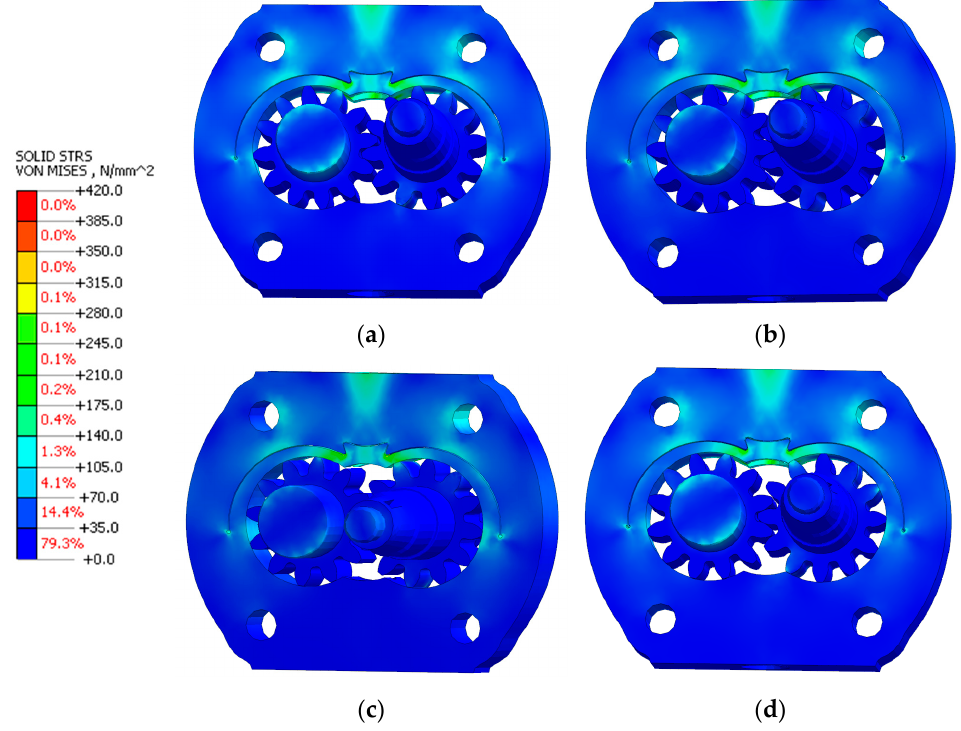
Figure 10. Distribution of stresses reduced acc. to the H-M-H hypothesis in casing D, gear rotation angle: ( a ) 0°, ( b ) 7.5°, ( c ) 15°, ( d ) 22.5°.